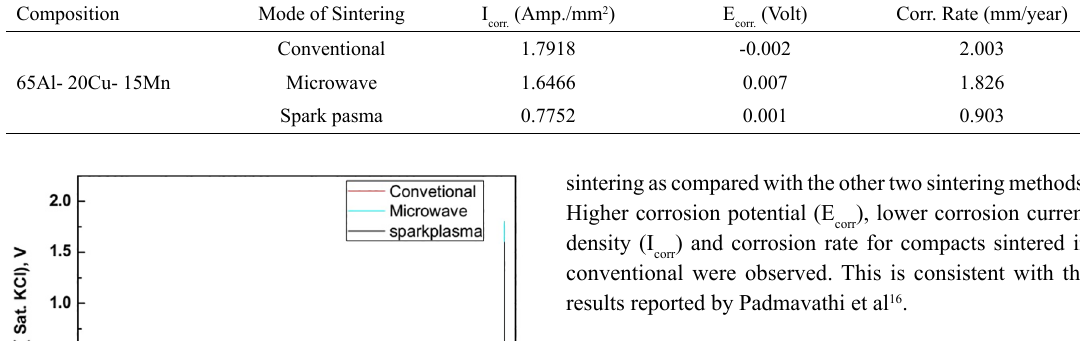
Table 3. Potentio-dynamic polarization values for the conventional, Microwave and Spark plasma Sintered samples. Composition